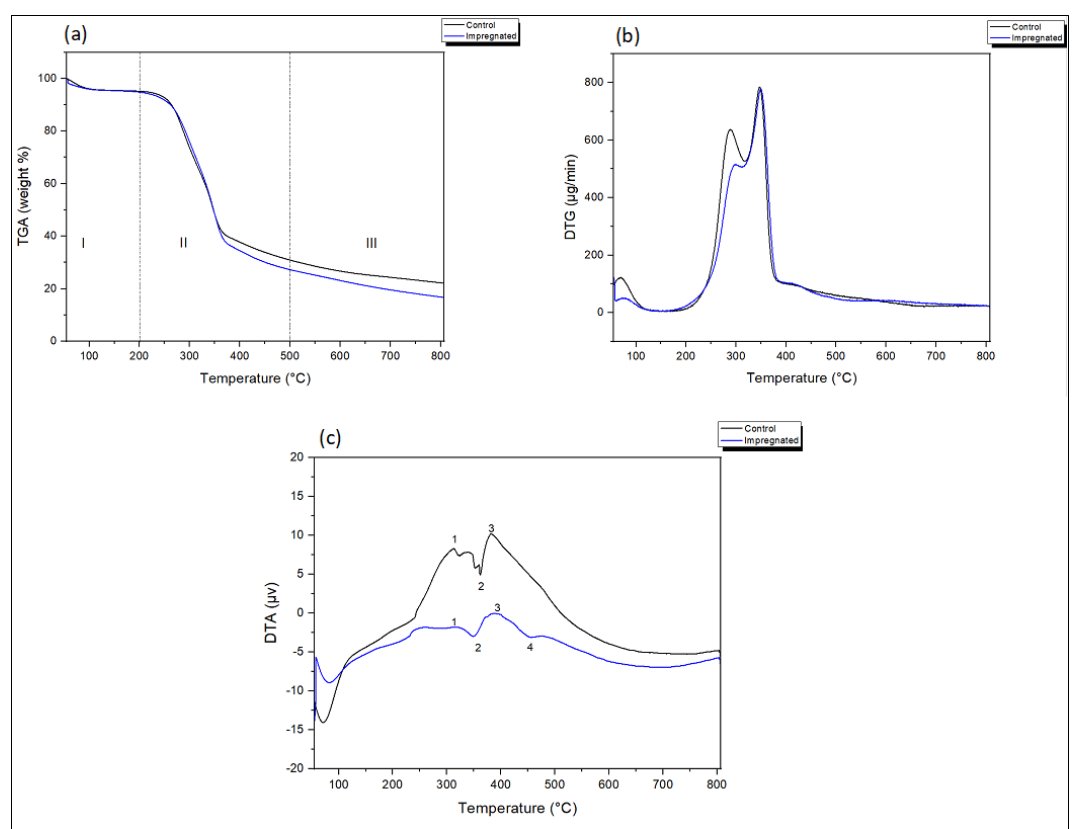
Figure 4. TGA ( a ), DTG ( b ) and DTA ( c ) of control and impregnated samples.